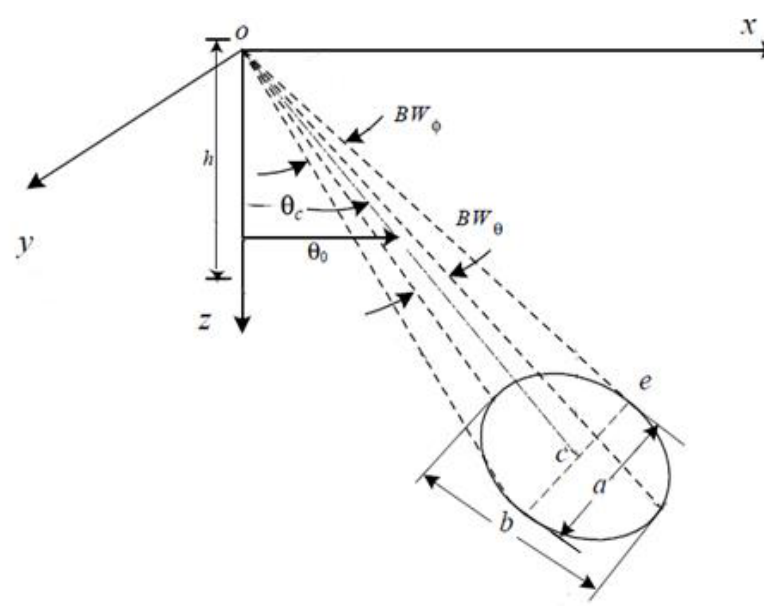
Figure 4. Cellular footprint of a UAV using a MIMO antenna.